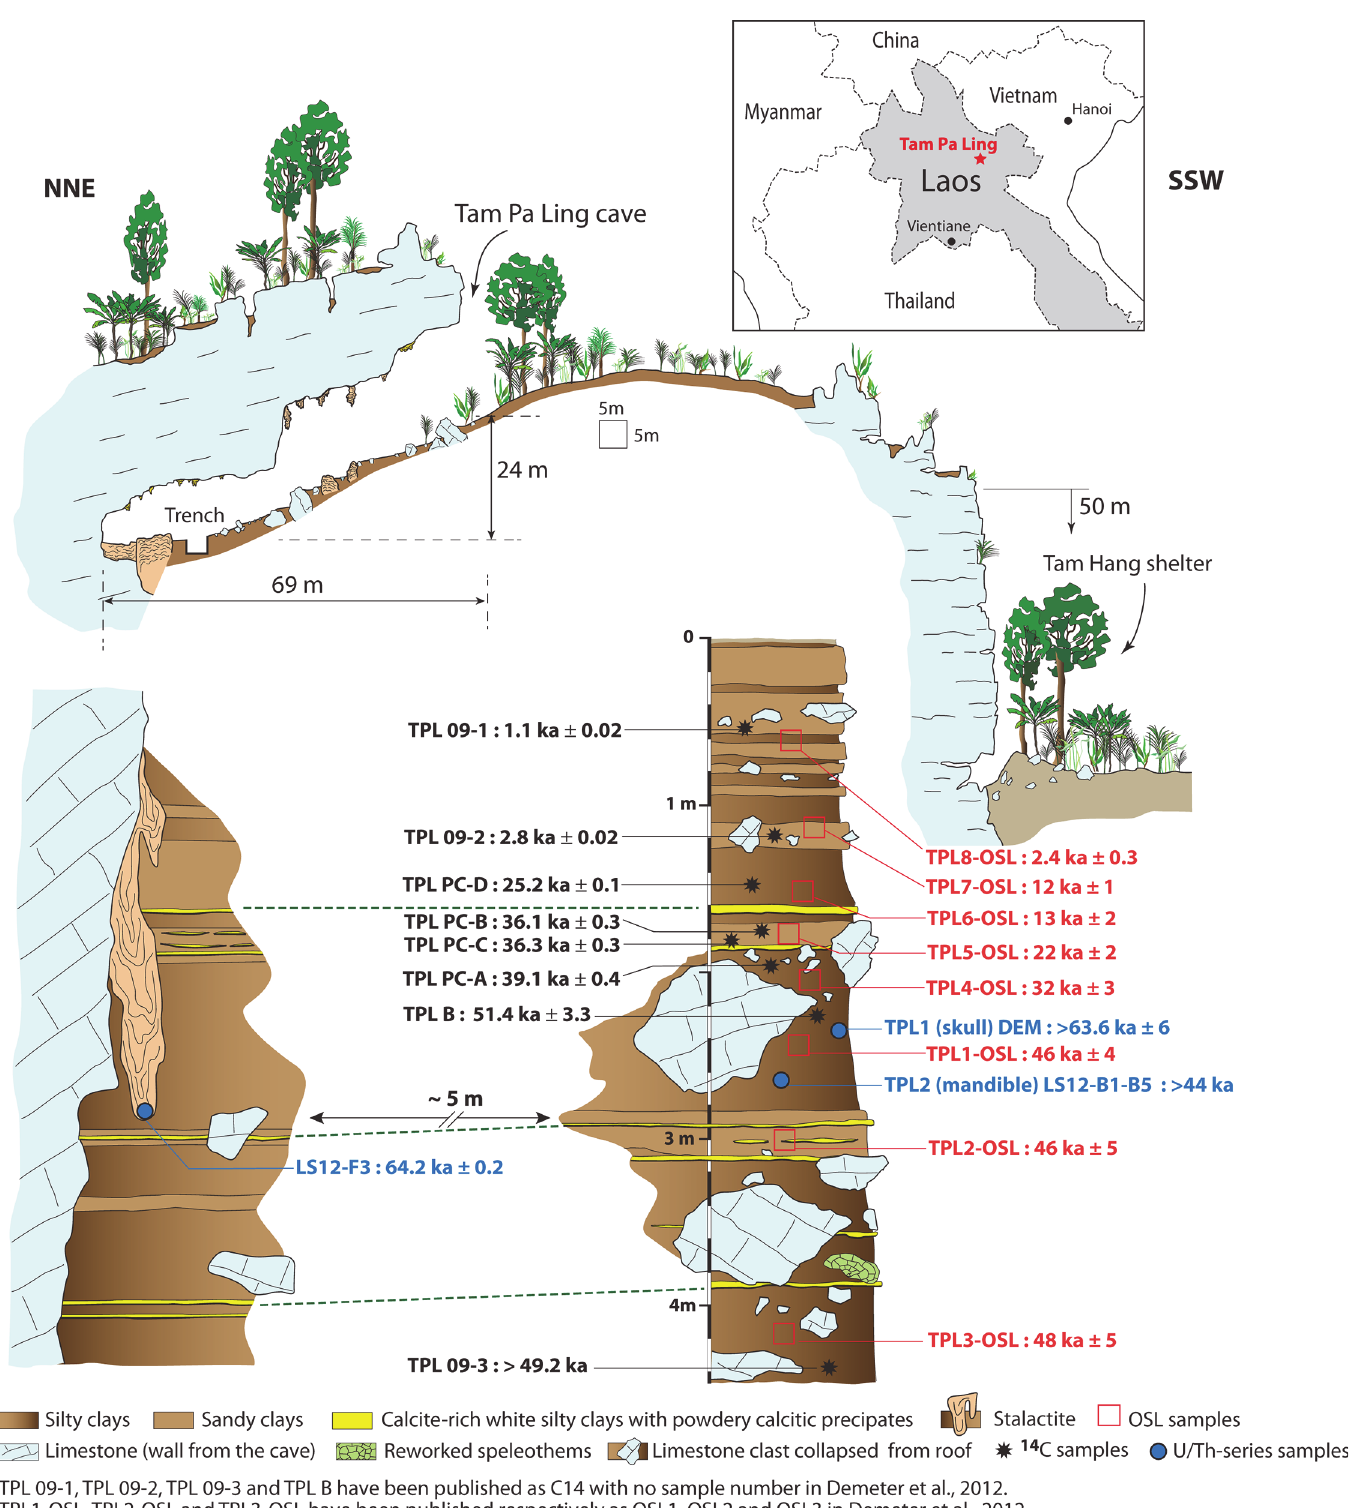
Fig 1. Site of Tam Pa Ling, Laos. TPL is located on the upper plateau of the Pa Hang Mountain with the Tam Hang rock shelter at the mountain ’ s base. The 4.5 m stratigraphic section shows the accumulation of sandy and silty clay layers punctuated by seven powdery, calcitic precipitates from the TPL trench.